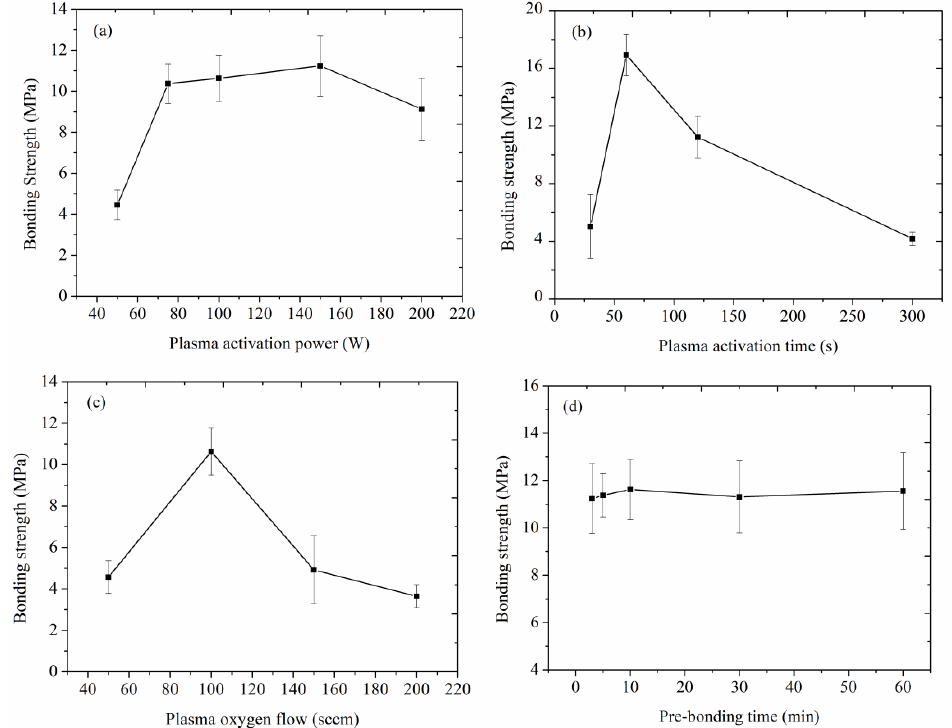
Figure 7. Bonding strength with ( a ) plasma activation power (with O 2 flow of 100 sccm, activation time of 120 s), ( b ) plasma activation time (with activation power of 150 W, O 2 flow of 100 sccm), ( c ) plasma O 2 flow (with activation power of 100 W, activation time of 120 s), ( d ) pre-bonding time (with activation power of 100 W, O 2 flow of 100 sccm, activation time of 120 s).